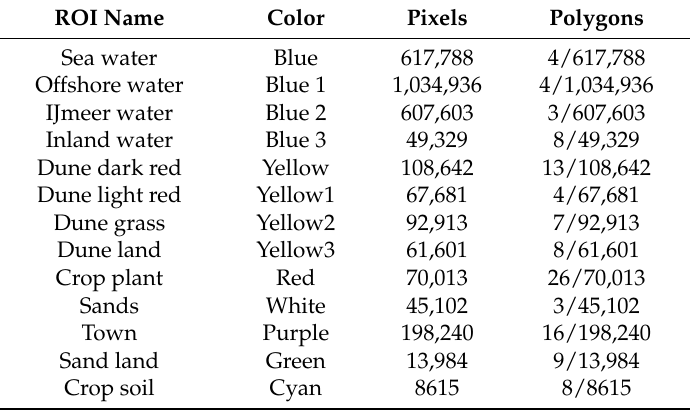
Table 3. Training sample list.